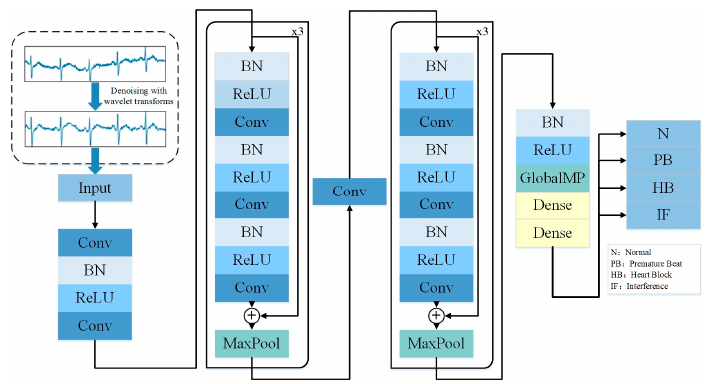
Figure 4. Structure of the proposed one-dimensional convolutional neural network (1D-CNN) model.